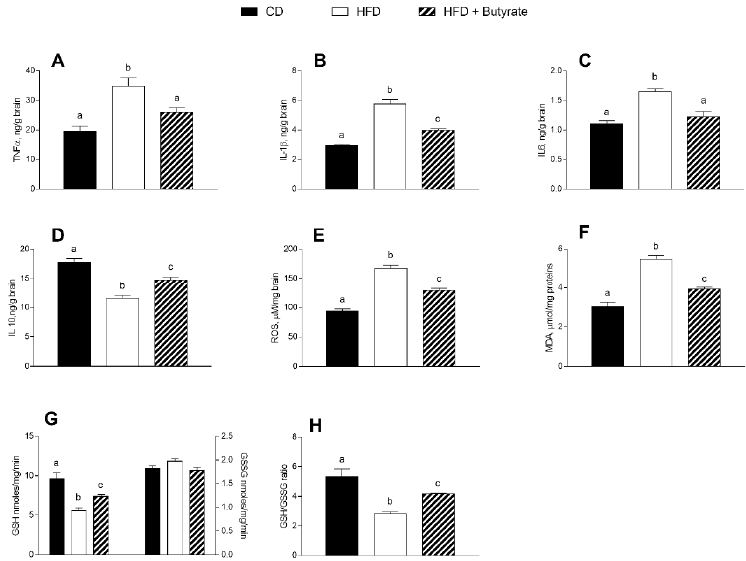
Figure 3. Effects of butyrate treatment on inflammation and oxidative stress in the brain cortex of diet-induced obese mice: ( A ) TNF- α ; ( B ) IL-1 β ; ( C ) IL-6; ( D ) IL-10; ( E ) ROS; ( F ) MDA; ( G ) glutathione (GSH) and oxidized glutathione (GSSG) and ( H ) GSH/GSSG ratio are reported. Data are shown as means ± SEM from n = 6 animals/group. Different letters (a,b,c) on top of the bars indicate statistically significant differences ( p < 0.05) among groups.